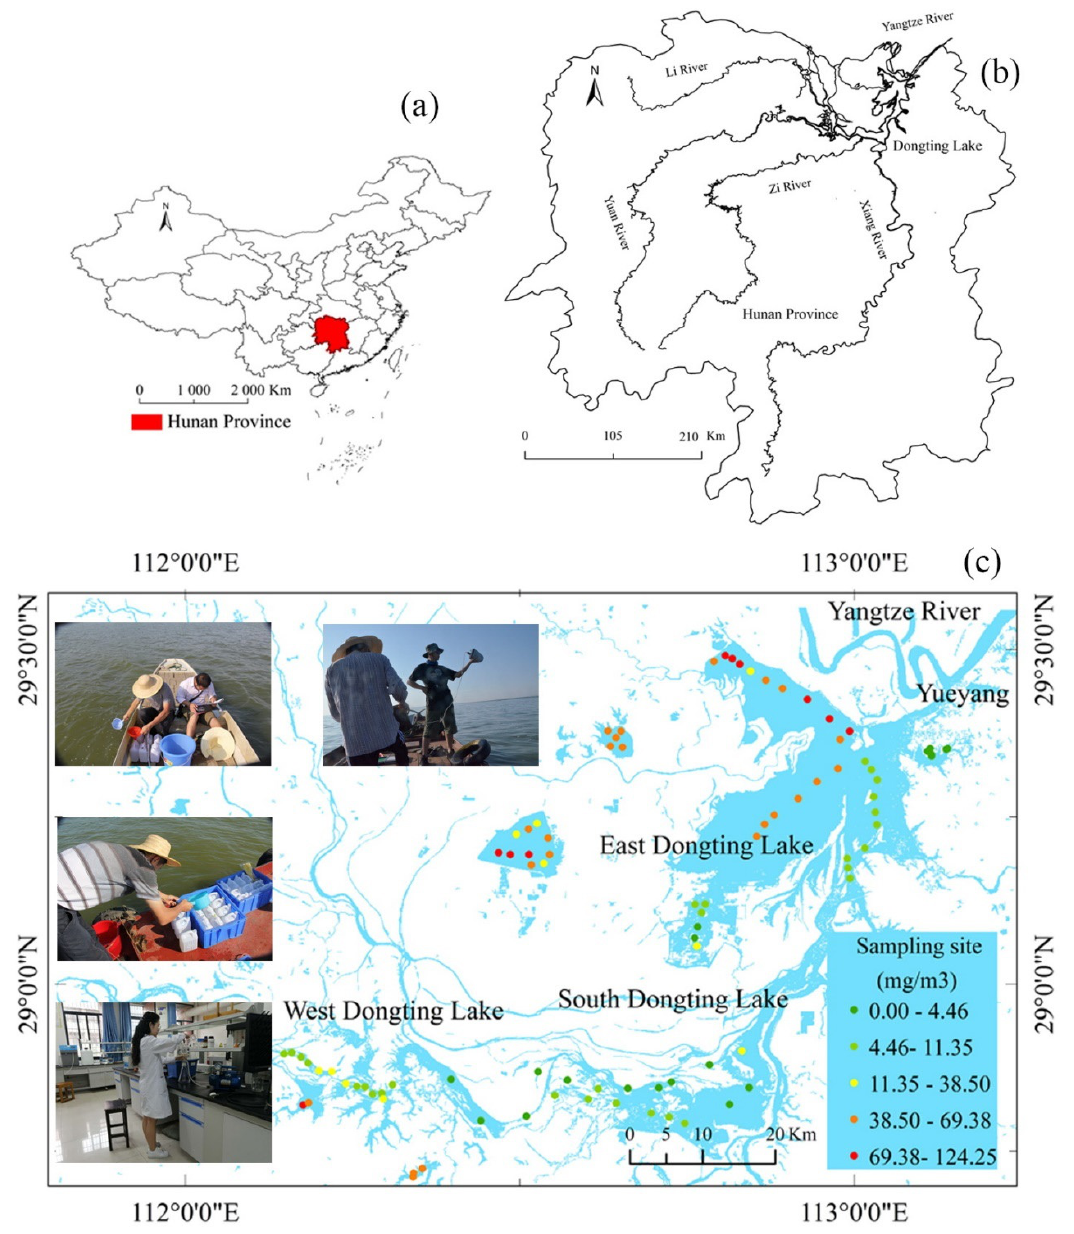
Figure 1. Location of sampling points. ( a ) Map of China. ( b ) Location map of Dongting Lake in Hunan ( c ) The location of sampling points and the distribution of chlorophyll concentration in Dongting Lake.